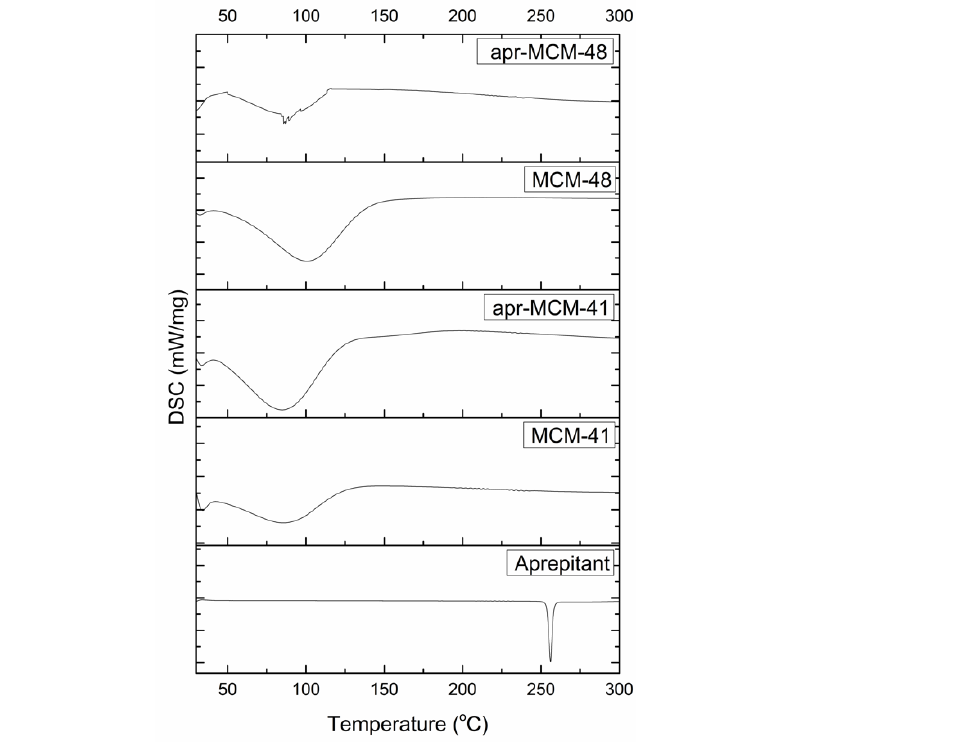
Figure 6. Differential Scanning Calorimetry (DSC) analysis of the pristine and drug loaded MSN particles.